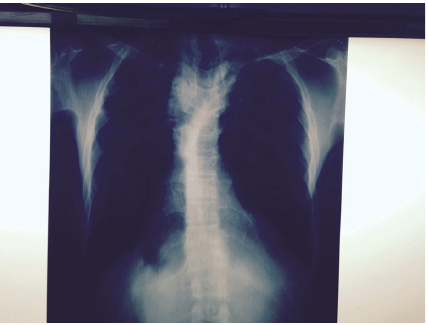
Figure 5: Chest X-ray after 17 months showing a fully expanded lower lobe and the same fibrosis in both lungs with no change.